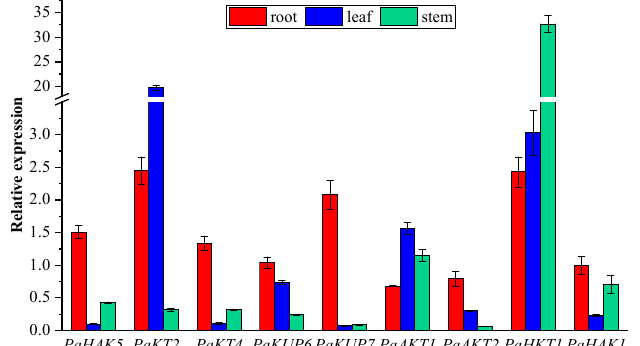
Figure 6. Expression level of high-affinity K + transporter genes in different tissues. The expression of a known gene PaHAK1 in root was normalized as value 1. Three biological replicates were performed in qRT-PCR ( n = 3).